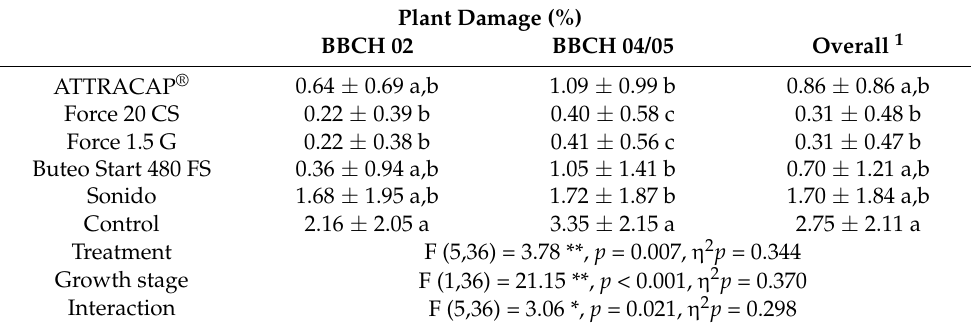
Table 3. Plant damage depending on the insecticidal treatment in 2019.